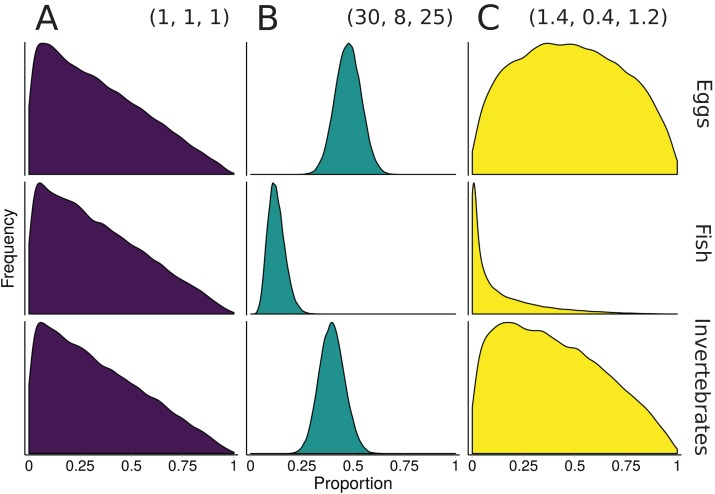
Illustration of alternative priors for a mixing model of rainbow trout (consumers/mixture) diet comprised of three sources: eggs, fish, and invertebrates.(A) The “uninformative”/generalist Dirichlet prior MixSIAR uses by default, α = (1, 1, 1). (B) A strongly informative prior with α = (30, 8, 25), where each αk corresponds to the sample size of source k from stomach contents. (C) A moderately informative prior with the same mean, but each αk rescaled such that Σαk = 3, the number of sources. Note that both informative priors have the same mean but differ in their “informativeness.”